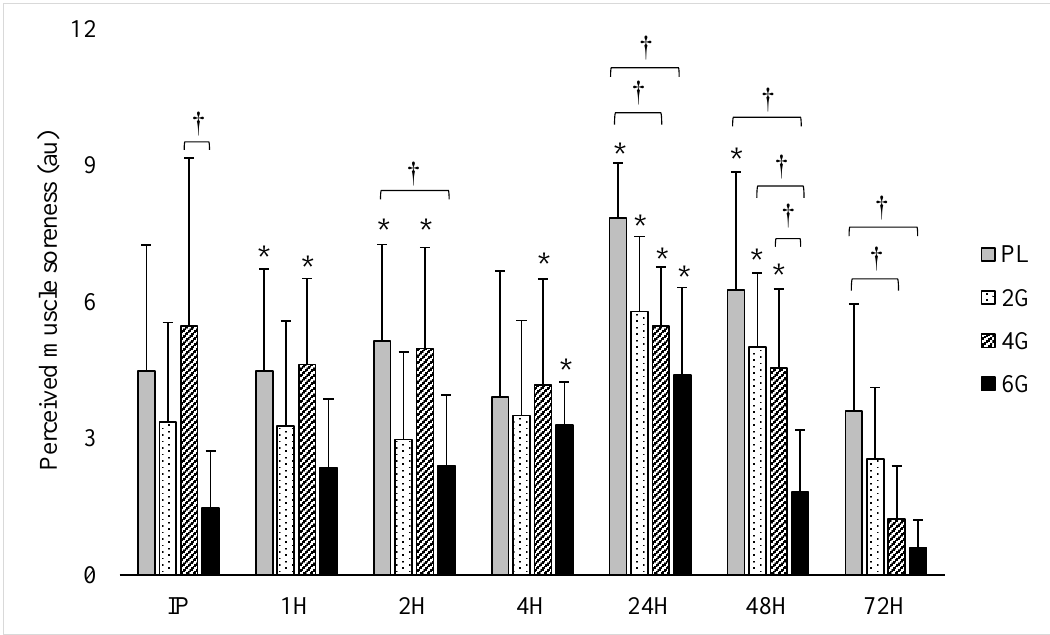
Figure 3. Effect of fish oil supplementation dosing on perceived muscle soreness following resistance exercise (mean ± SD). (n = 8/group; 4 males and 4 females per group). * Significant ( p < 0.05) difference from PRE. † Significant ( p < 0.05) difference between groups.